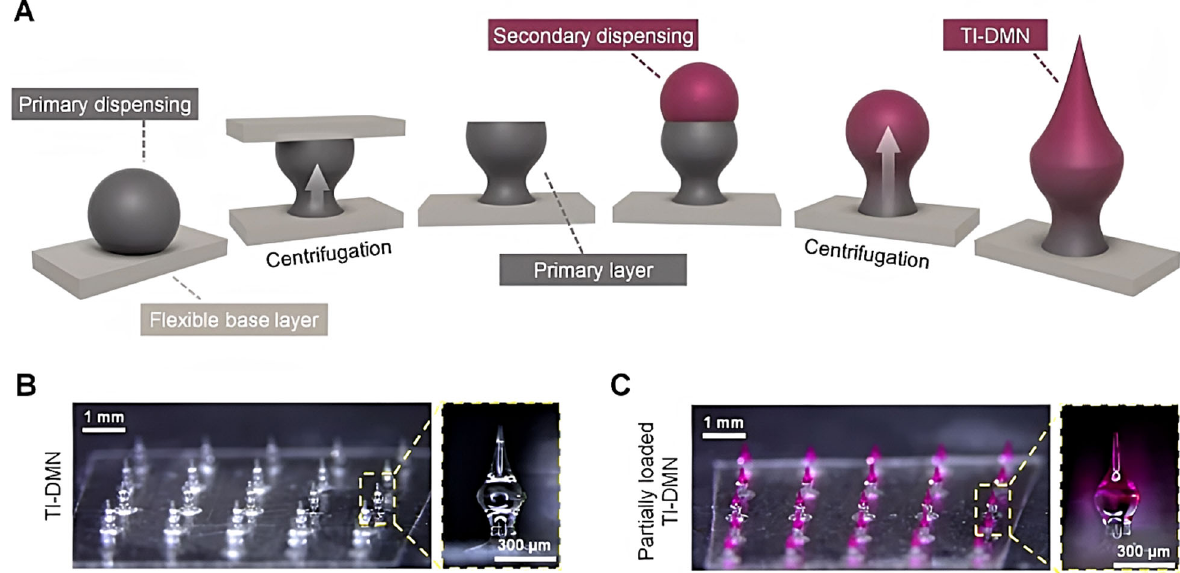
Figure 4. Schematic representation of hyaluronic acid-based tissue-interlocking dissolving microneedles. ( A ) Fabrication steps, ( B ) microscopic images, ( C ) microneedle partially loaded with Rhodamine B. Images reprinted with permission from [210].